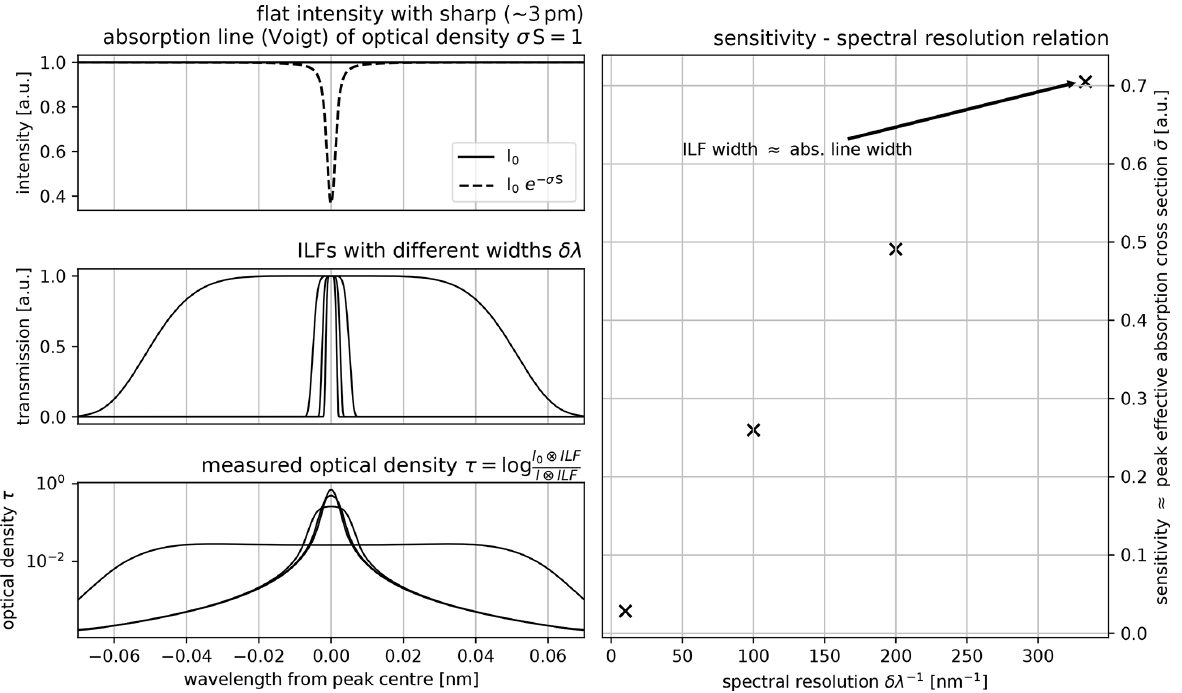
Figure B1. The absorption of a sharp line is diluted throughout the ILF of the observing spectrograph. For ILF widths δλ that are much larger than the width of the absorption line, the measured absorption signal (peak optical density, i.e. peak effective absorption cross section σ ) increases approximately linearly with spectral resolution. For this visualisation, the ILF was modelled with a sixth-order Gaussian, and a Voigt profile was assumed for the absorption